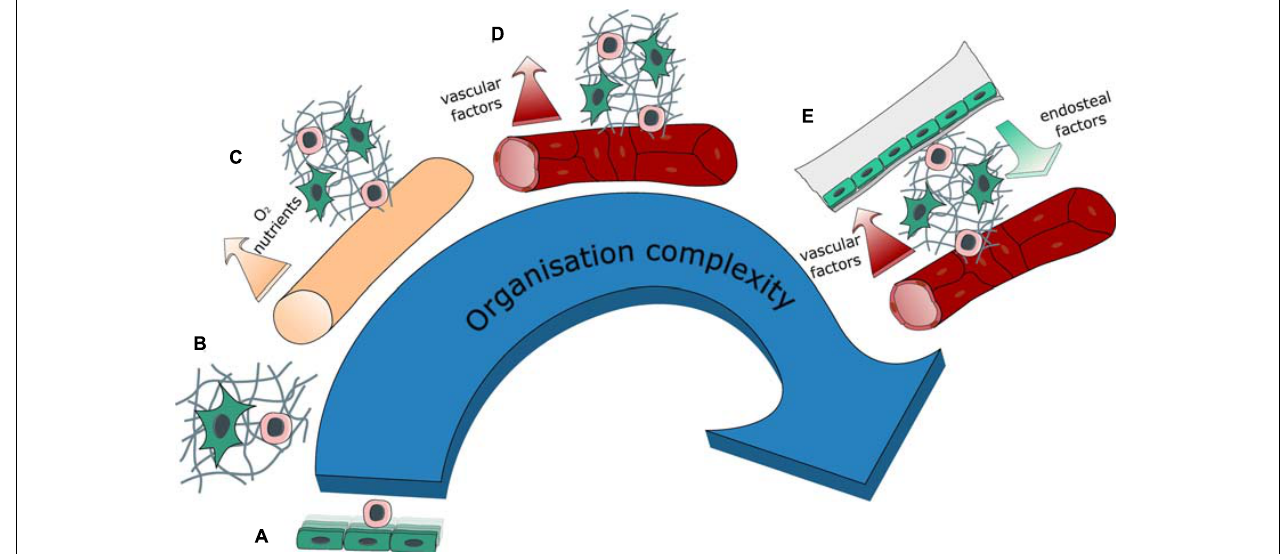
FIGURE 3 | Evolution of system complexity over time. Evolution in the organization complexity of engineered BM models with: (A) 2D co-cultures (feeder cells), (B) 3D co-culture within a hydrogel, (C) introduction of a source for medium renewal with either perfusion or the creation of a hollow tube, thus generating compartments within the tissue, (D) introduction of vasculature (self-assembled or engineered) bringing contact-dependent interaction in addition to compartmentalization, (E) introduction of a bone environment generating a segmented endosteal and vascular regions, with different ECM and cellular contents as well as different physical